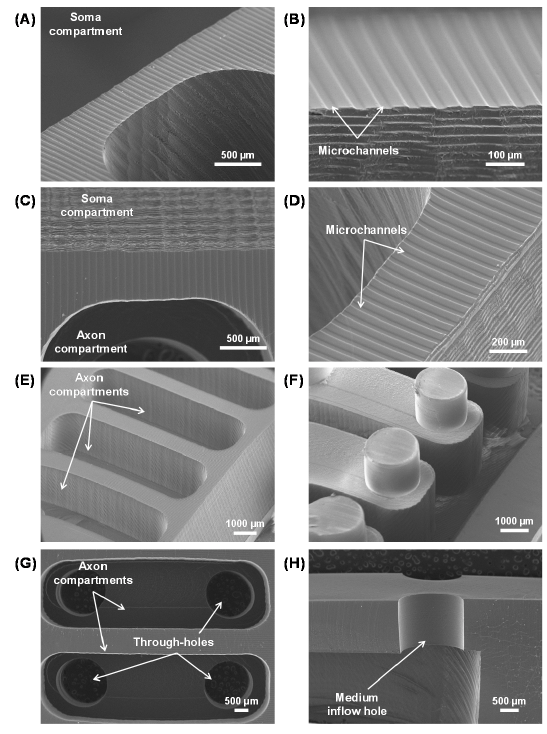
Figure 3. SEM images of the fabricated devices: ( A , B ) PMMA master showing precisely patterned microchannel array by the hot-embossing process; ( C – E ) bottom-side of the final PDMS layer showing 3 µ m deep and 20 µ m wide microchannels connecting the soma compartment and the axon compartments; ( F ) axon compartment of the PDMS master, in which the round pillar-like structures allows pre-defined holes to be made on the final PDMS layer; and ( G , H ) pre-defined through-holes on the axon compartments of the final PDMS